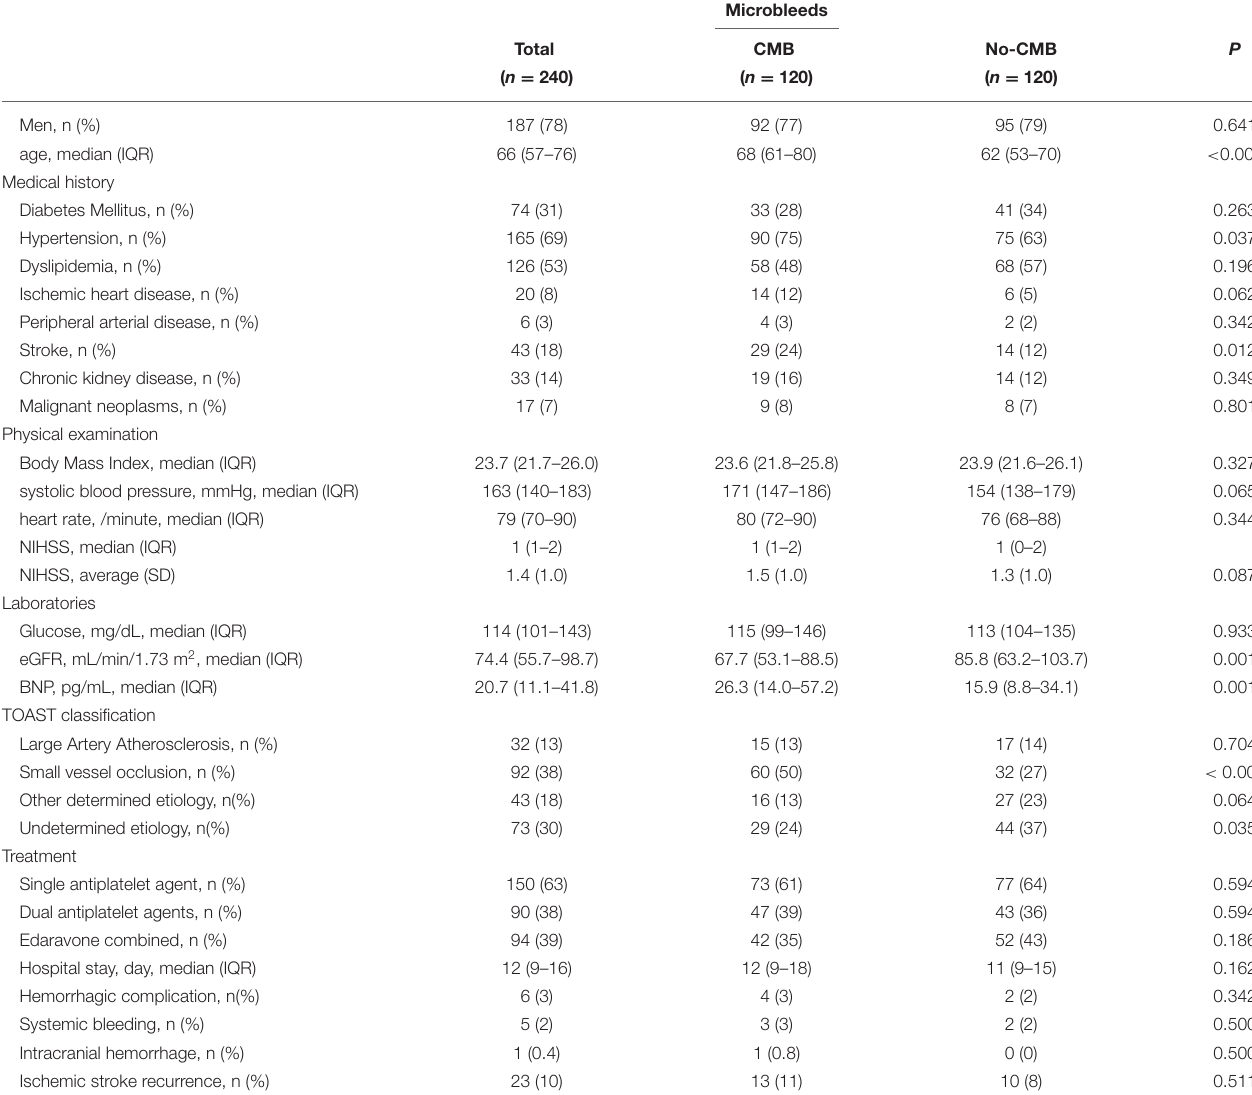
TABLE 1 | Baseline characteristics of the study